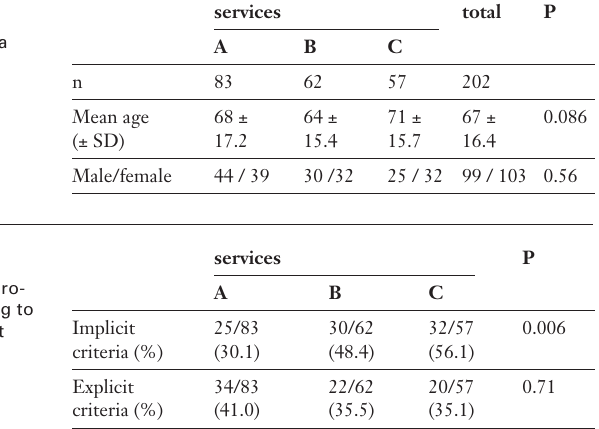
Demographic data of patients.